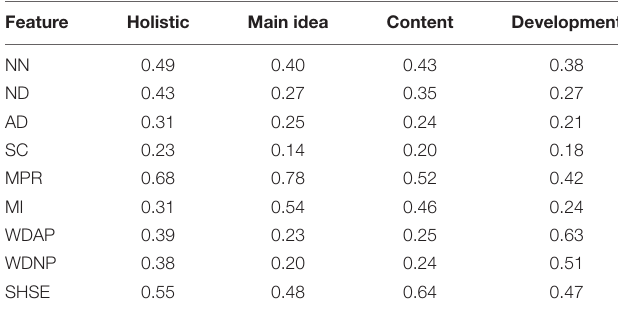
TABLE 6 | Average correlations (across all prompts) of feature values with H2.